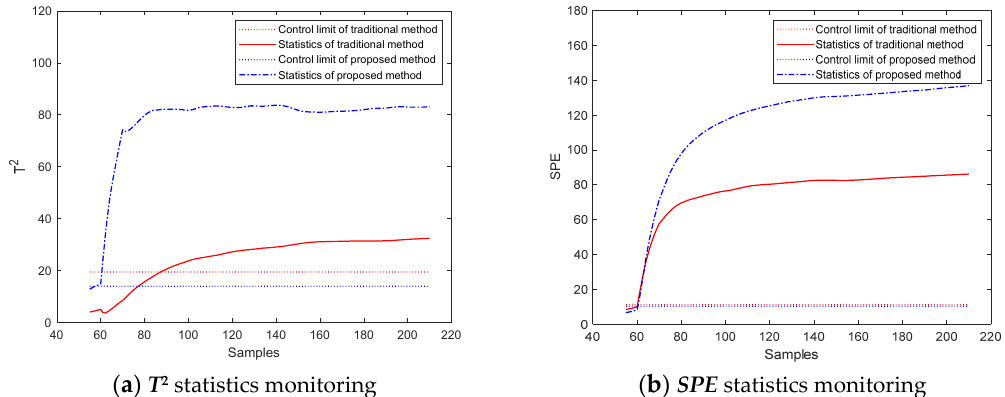
Figure 10. Single-mode online monitoring of material disturbance fault. For the sensor fault, a test batch with the pressure variable removed after the 150th sampling point is monitored. The T 2 and SPE monitoring effects of the traditional method and the proposed method of the single-mode model are shown in Figure 11. Compared the amplitudes are relatively large.